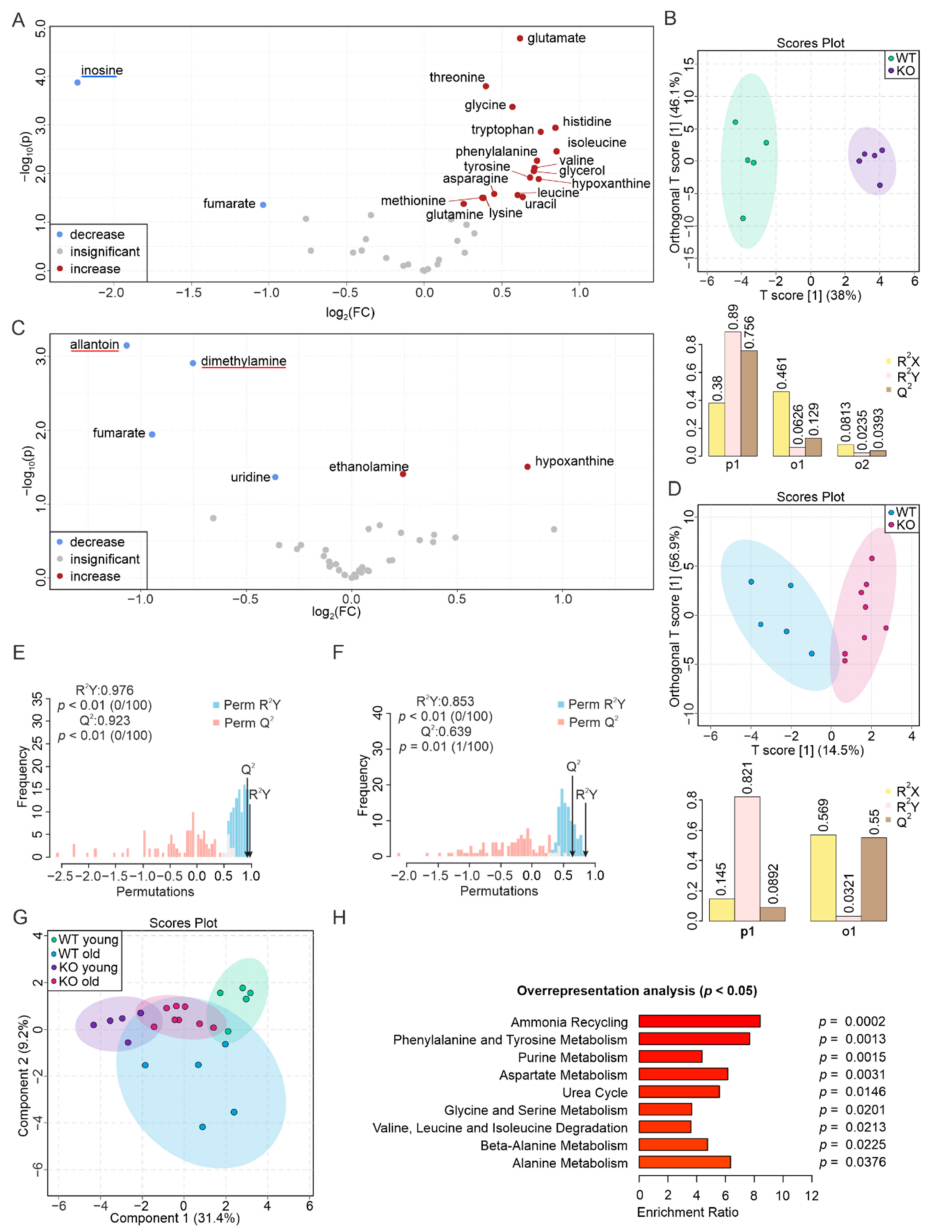
Figure 8. PEMT deficiency severely affects the metabolome of young ilea. ( A ) Volcano plot showing differences in the metabolite concentrations between WT and PEMT KO ilea from young mice. Red, blue, and grey dots correspond to significantly increased, decreased, and insignificantly changed metabolites, respectively. Blue underline indicates an aging biomarker whose concentration decreases upon aging in the WT ileum. ( B ) O-PLS-DA plot of WT ( n = 5, green) and KO ( n = 5, purple) ileum samples from young mice (upper panel), and cross-validation coefficients R 2 X, R 2 Y, and Q 2 of p1, o1, and o2 (lower panel). ( C ) Volcano plot showing differences in metabolite concentrations between WT and PEMT KO ilea from aged mice. Red underlines highlight aging biomarkers whose concentrations increase upon aging in WT ilea. ( D ) O-PLS-DA plot of WT ( n = 5, blue) and KO ( n = 8, pink) ileum samples from aged mice (upper panel), and cross-validation coefficients R 2 X, R 2 Y, and Q 2 of p1 and o1 (lower panel). ( E ) Histogram showing permutation test of samples in ( B ) and ( F ) of samples in ( D ) with permutation number n = 100, respectively. ( G ) S-PLS-DA plot of the 4 ileum groups, with green, purple, blue, and pink corresponding to WT young, KO young, WT old, and KO old, respectively. ( H ) ORA of pathways associated with significantly changed metabolites in the ileum of young mice ( A ), with all pathways yielding p <